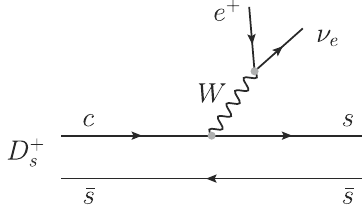
Fig. 1 Semileptonic D + s decay at the quark level